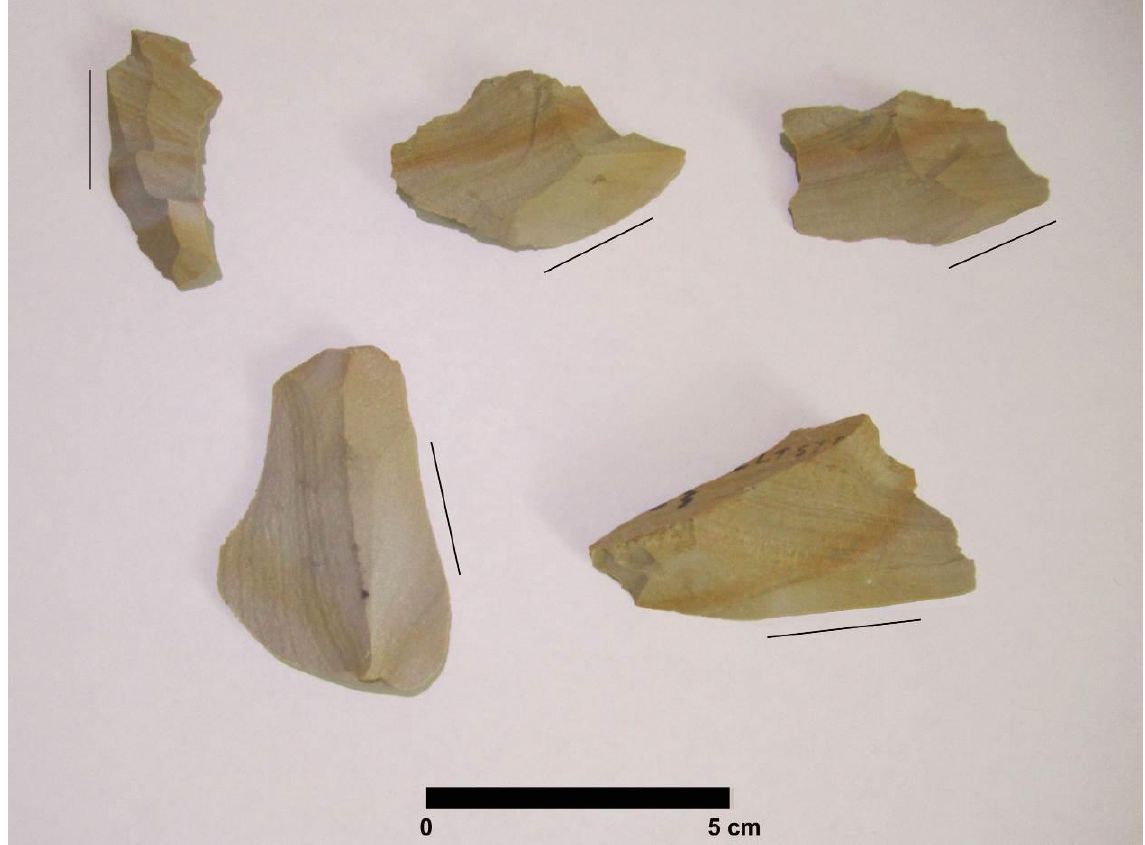
Figure 1: The experimental BB flake scrapers with utilized edges